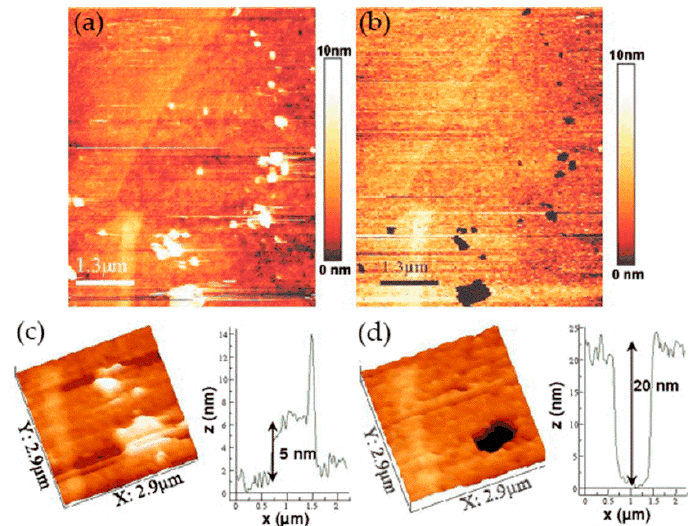
Figure 10. AFM images of the surface at open-circuit potential ( a ) and at pitting potential ( b ). ( c , d ) The pit chain (in black, right image) profiles made on images at higher magnification (bottom insets) show that the average relief of the islands was about 5 nm, whereas the average depth of the pits was about 20 nm. Reprinted with permission from Reference [46]; copyright 2008 Elsevier Ltd.